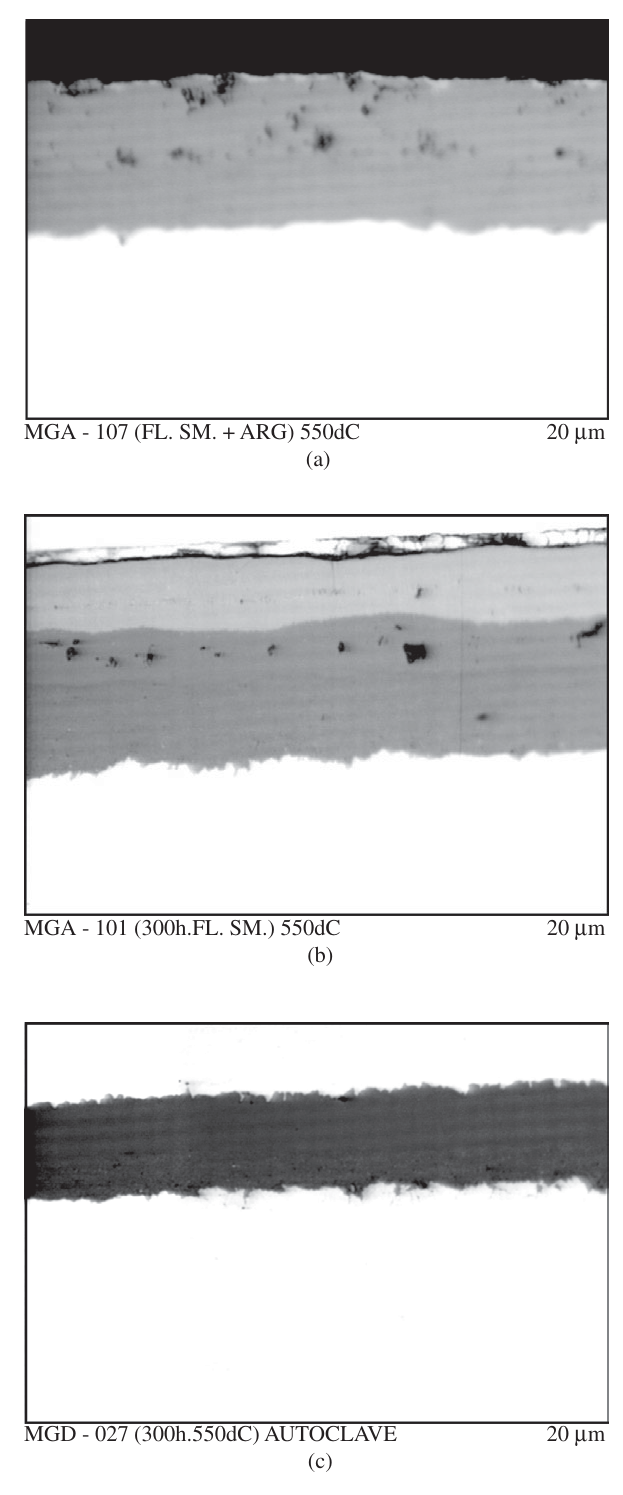
Figure 3. Microstructure of oxide scales grown on T22 ferritic steel at 550 °C for 300 h using different laboratory procedures: a) argon/50% H O; b) flowing steam; c) static high 2